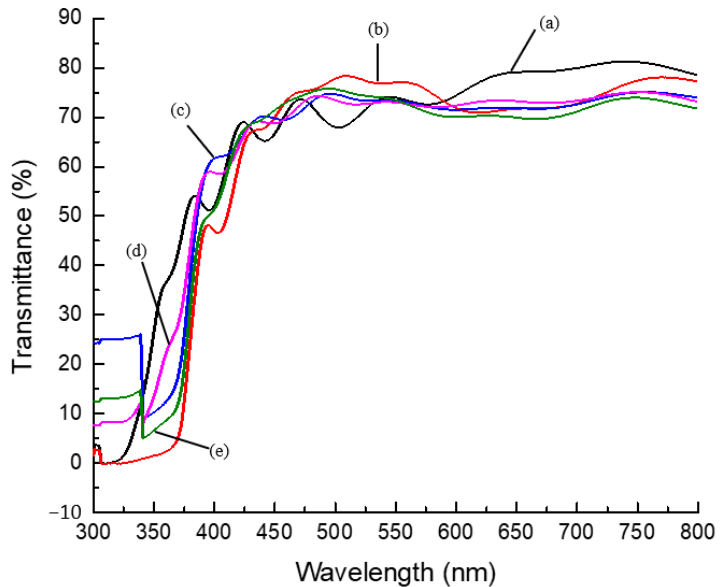
Figure 5. The transmittance spectra of ( a ) the n-TiO 2 /FTO substrate and the n-TiO 2 /ZnO bilayer thin films annealed for ( b ) 1, ( c ) 1.5, ( d ) 2, and ( e ) 2.5 h at 500 °C, respectively.